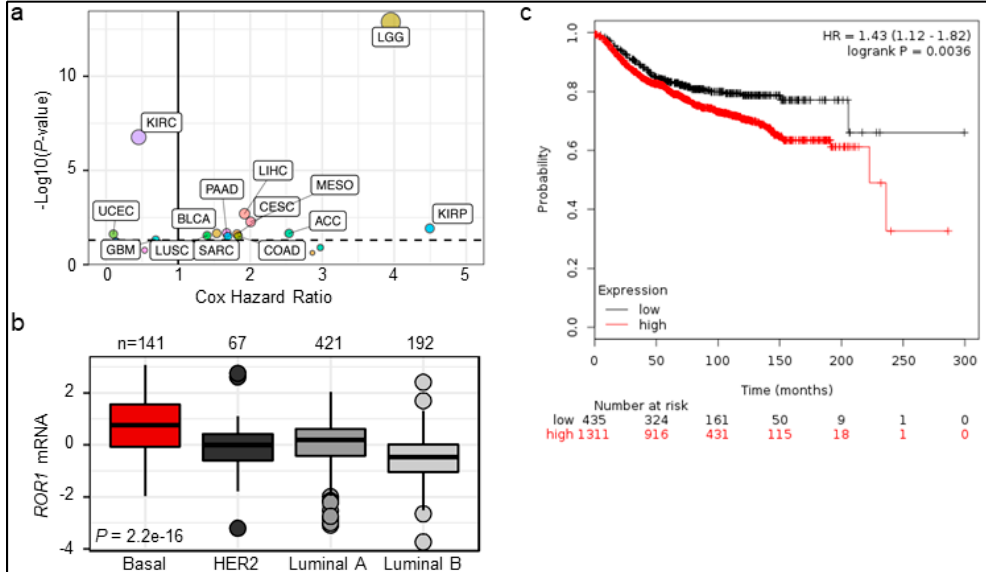
Figure 1. Higher expression of ROR1 is correlated with poor overall survival in several cancers. ( a ) Cox proportional hazard regression summary of hazard ratios and –log10 ( p -value) across the TCGA Pan Can cohort. Labeled points indicate significance of p < 0.05, which is also marked by the horizontal dotted line. ( b ) Z -score transformed mRNA for ROR1 across PAM50 subtypes in the breast cancer TCGA cohort. Samples compared using one-way ANOVA test. ( c ) KM plotter was used to analyze ROR1 expression and prognosis. Using ROR1 max probe: 205805_s_at and optimal cutoff, ROR1 mRNA is inversely correlated with distal metastasis free survival (DMFS) in all breast cancer patients ( n = 1311 in the ROR1-high group and n = 435 in the low group, p = 0.0036).